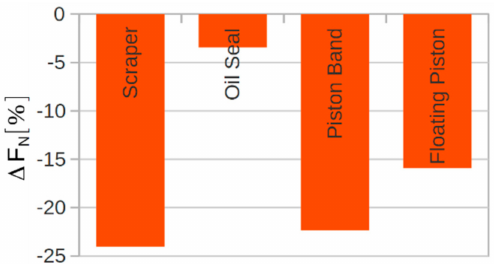
Figure 9. Contact normal force change (in percentage) during the material relaxation phase, depicted for each seal/counterpart FEM